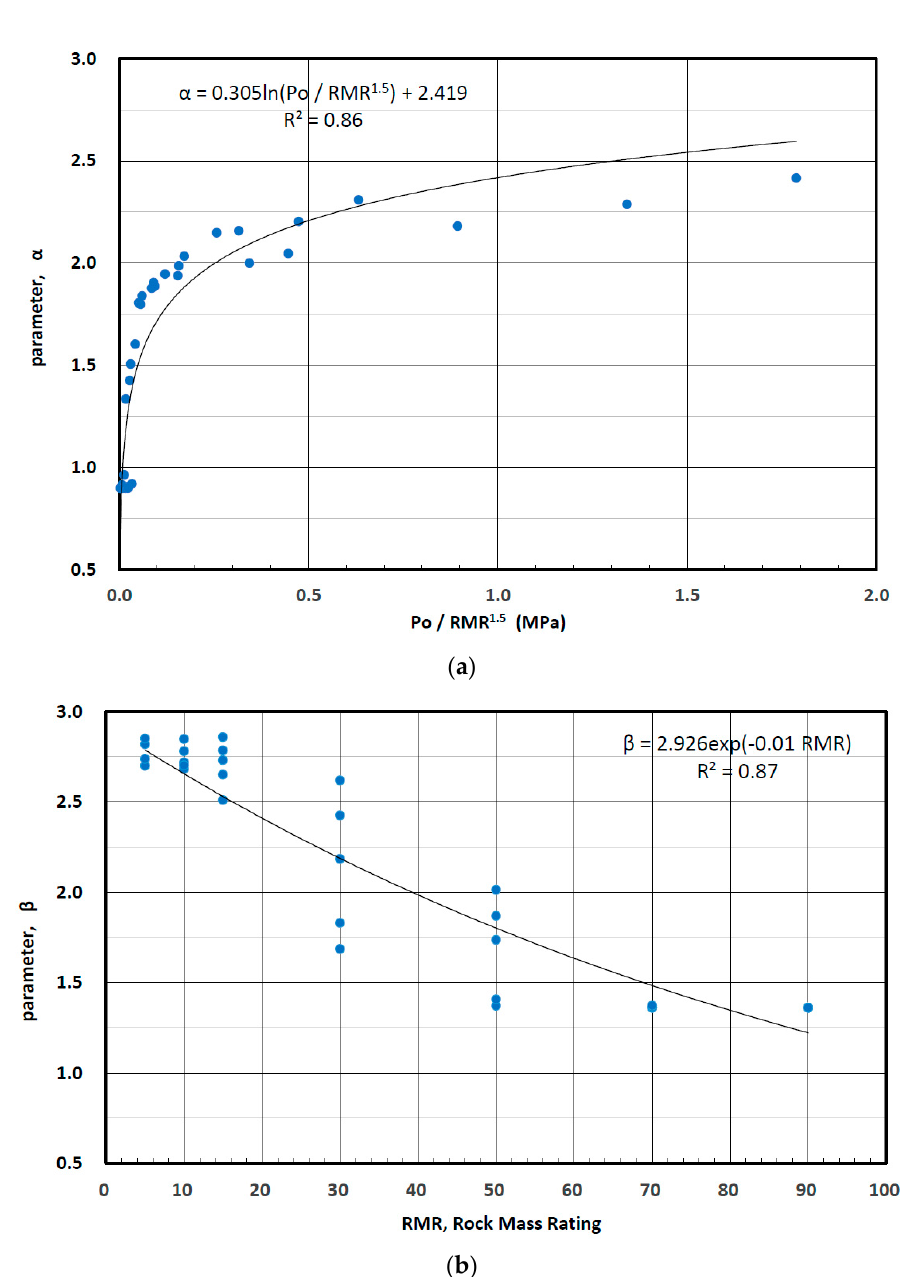
Figure 9. Regression analysis results for parameters ( a ) α and ( b ) β .